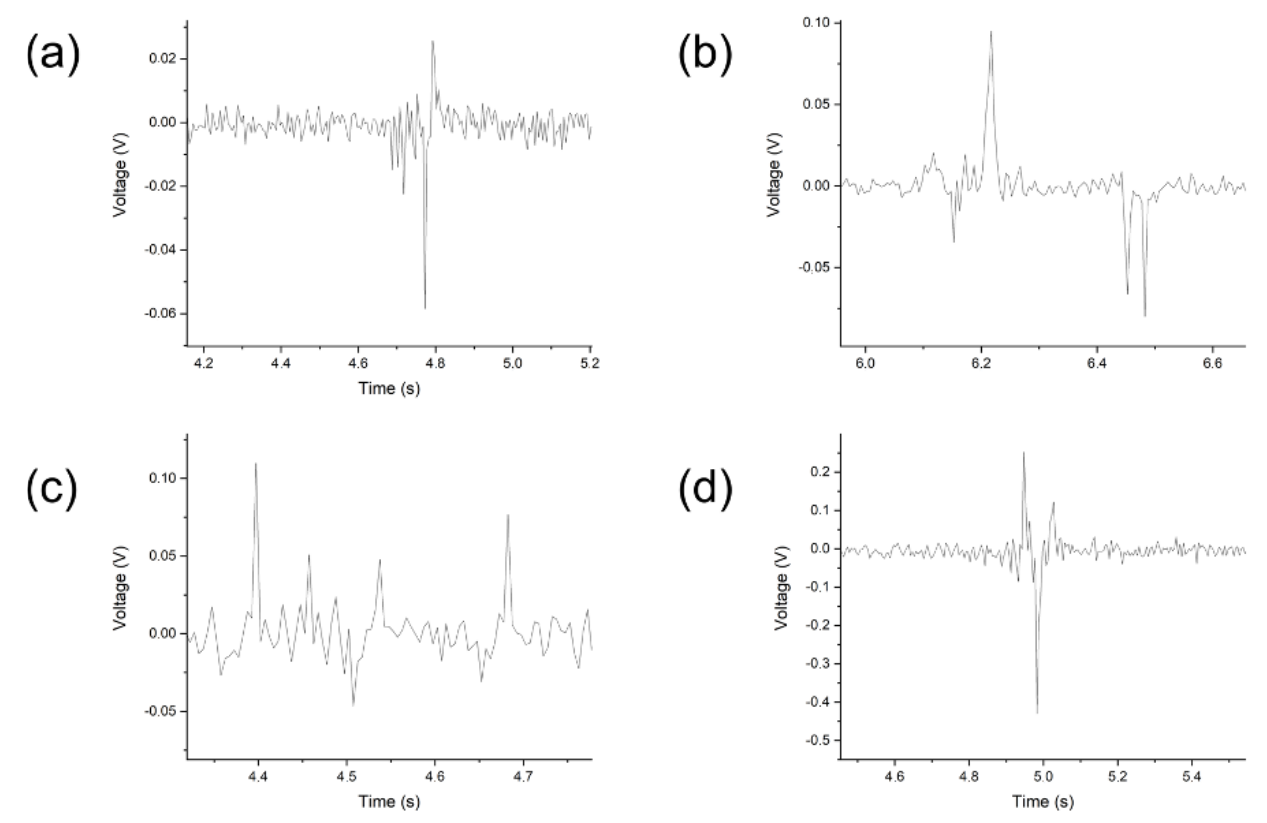
Figure 5. The piezoelectric response registered for different frequencies of the SbSI/PU nanocomposite: poling ( a – c ) and non-poling ( d ); 1 Hz ( a , d ); 3 Hz ( b ); 7 Hz ( c ).